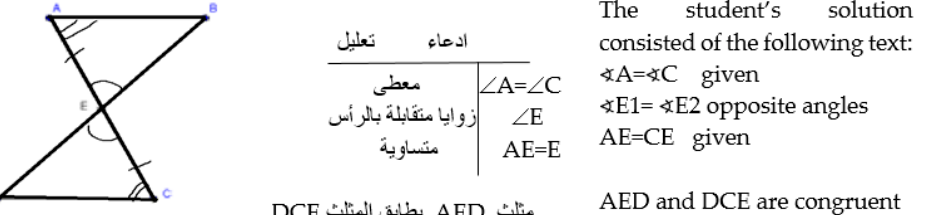
Figure 11. The congruence theorem is not mentioned.